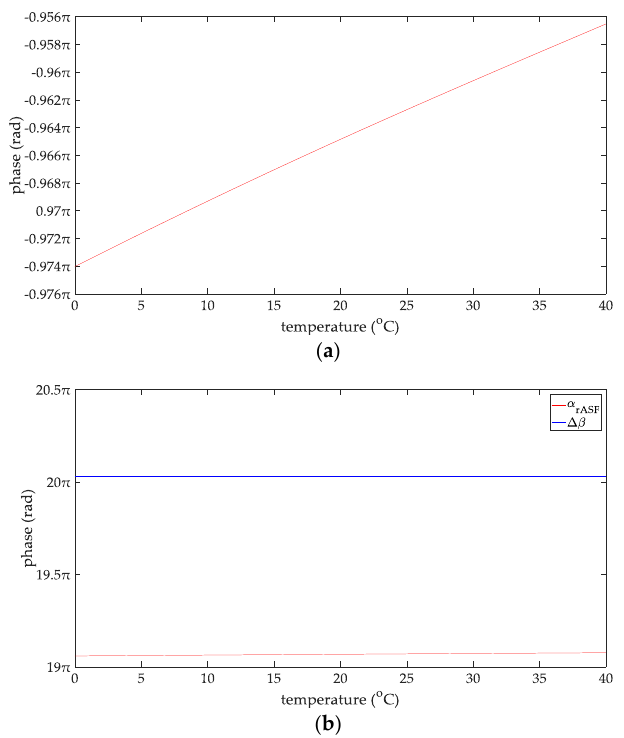
Figure 3. ( a ) The phases of the reflection coefficient changing with the sea temperature; and ( b ) the ASFs of the AIS reflected signal changing with the sea temperature.